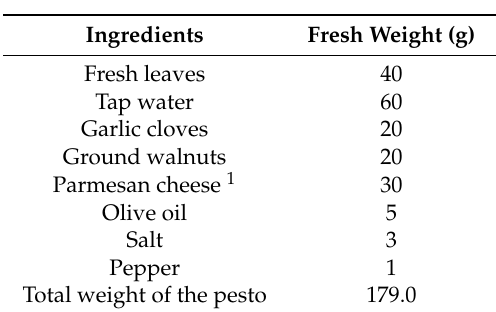
Table 1. Recipe for fat hen pesto (g fresh weight).